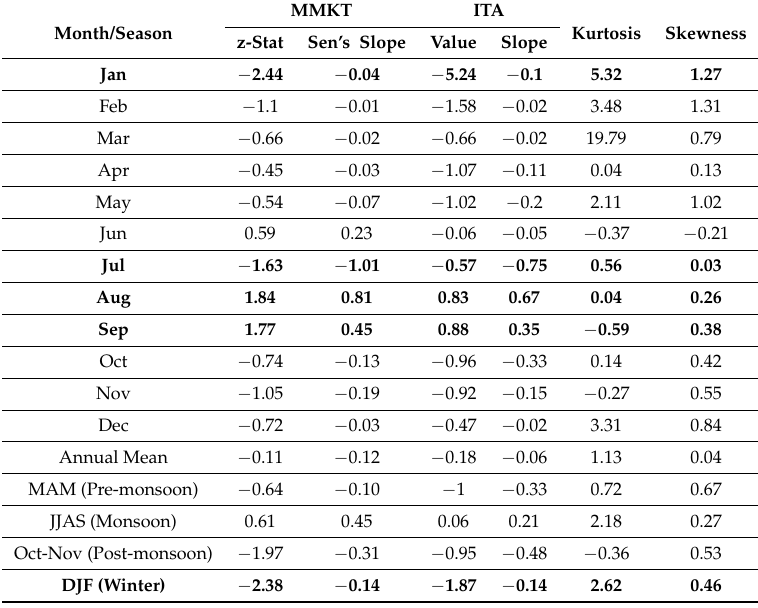
Table 2. Modified Mann–Kendall’s Test (MMKT), Sen’s slope, ITA, kurtosis, and Pearson’s coefficient of skewness test results. Unit of rainfall for all the categories is rainfall in mm. Slope values for Sen’s slope and ITA are in mm year − 1 . Bold style represents 90% level of significance in trend